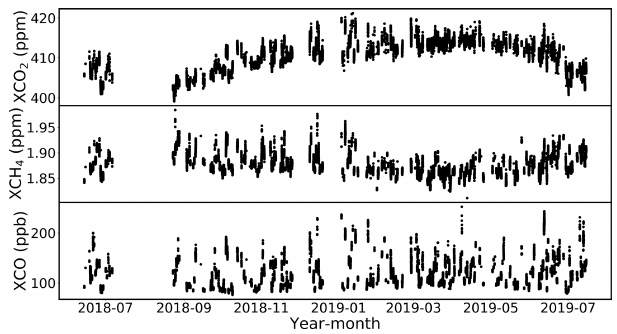
Figure 8. Time series of XCO 2 , XCH 4 and XCO covering the pe- riod from 14 June 2018 to 19 July 2019.